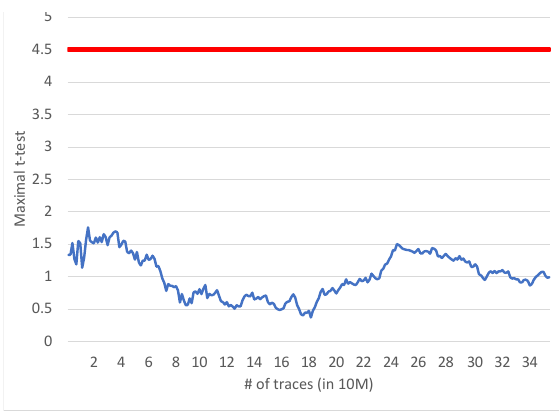
Figure 4: Maximal t-test vs. number of traces for redundancy 8 (16 Sboxes with re- randomization)